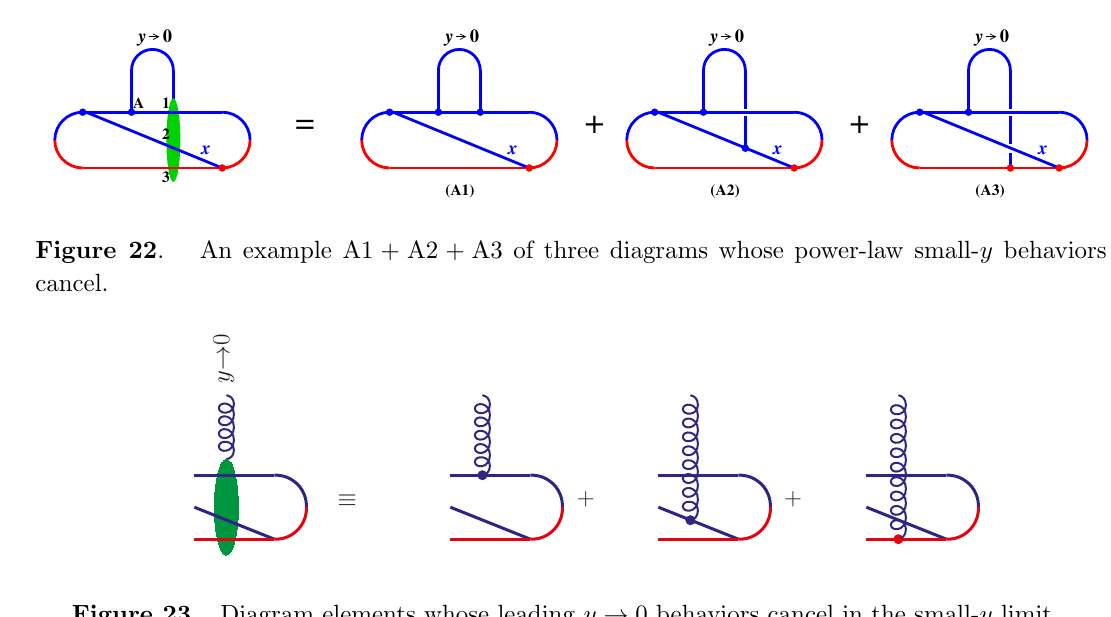
Figure 23 . Diagram elements whose leading y